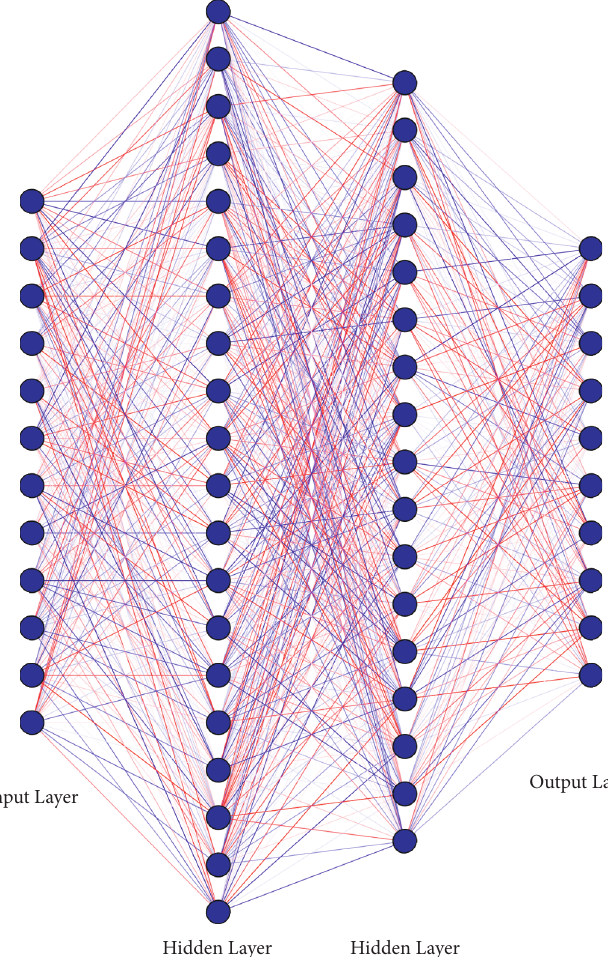
Figure 1: Structure of a NAR artificial neural